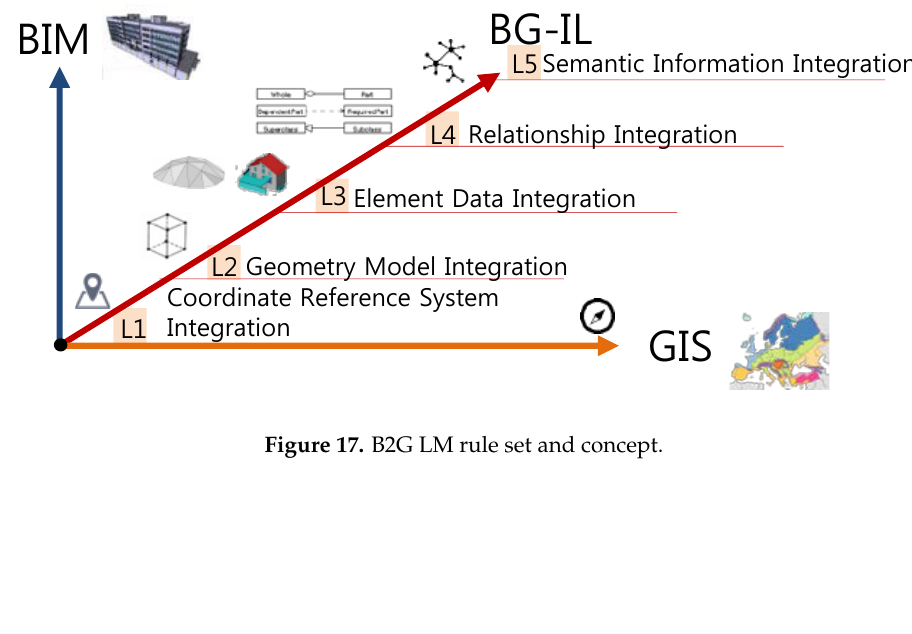
Table 10. BG-IL use-case examples.